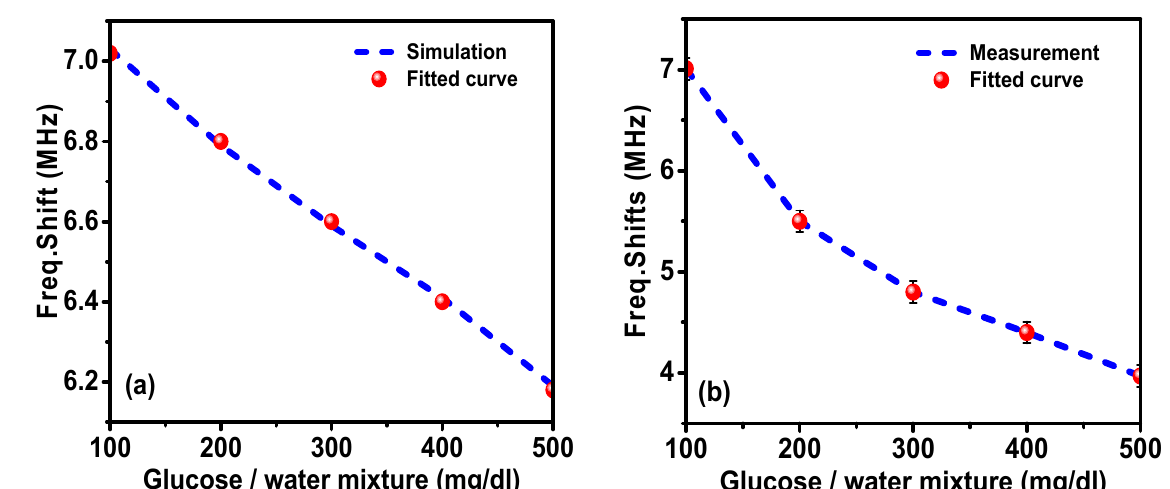
Figure 13. Resonance frequency shift versus the glucose concentration in water: ( a ) simulation and fitted curve, and ( b ) measurement and fitted curve.